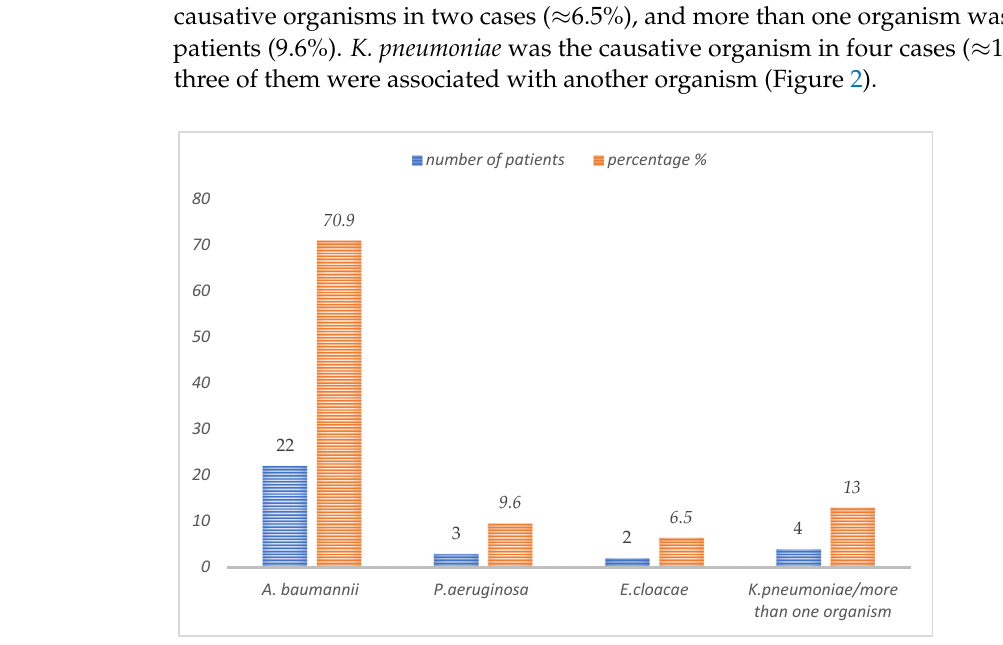
Figure 2. Causative organisms of CNS infections in pediatric patients treated with IV/IT colistin. The route of infection in the review cases was mainly after neurosurgical interven- tions (26 cases, 83.8%). An external ventricular drain was inserted in 29 cases (93.5%). The median duration for colistin therapy was 18 days. Twenty-three patients (74%) recovered, while five patients (16%) had residual disability, and three patients (10%) died. Table 1. Summary of the main findings of the included studies. Reference